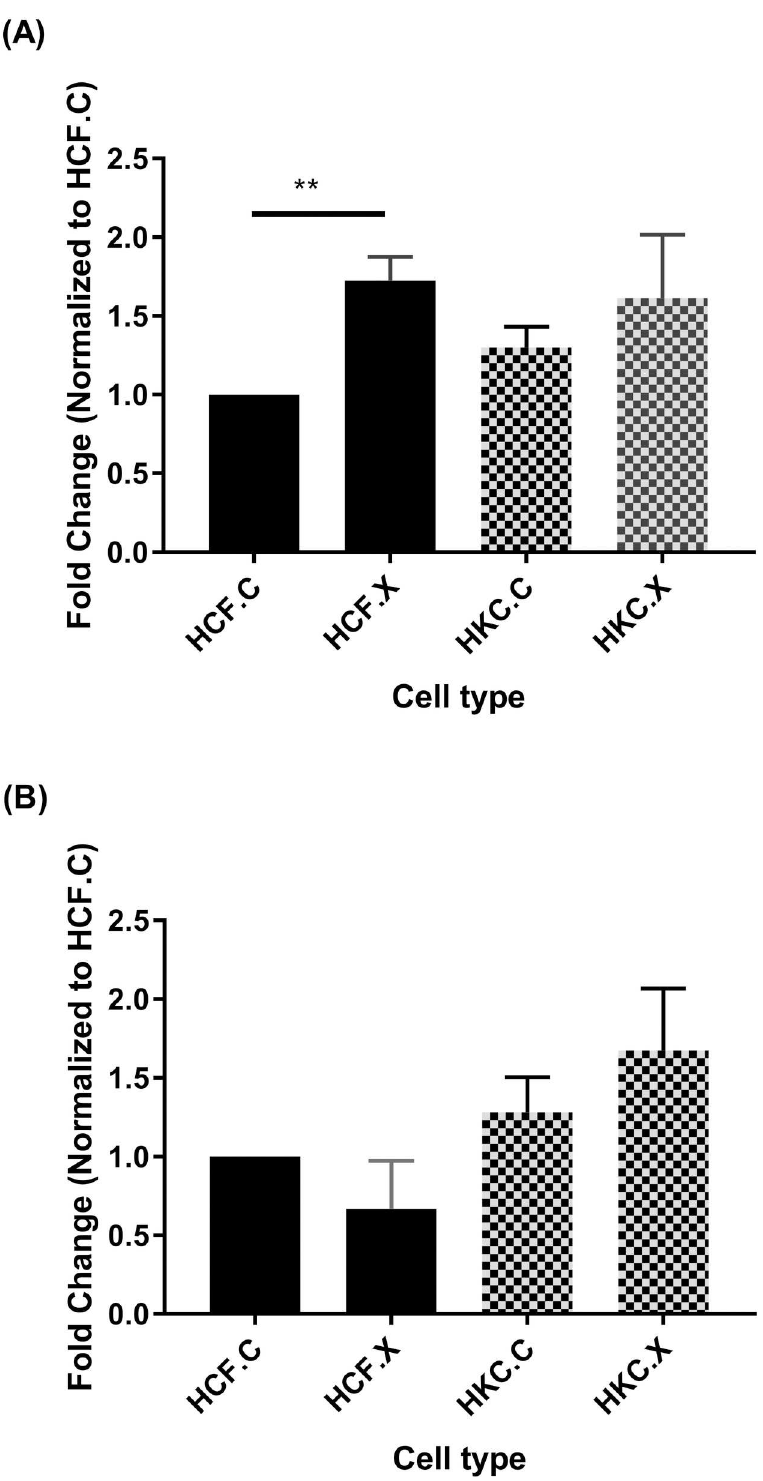
Fig 4. CXL shows no significant impact on protein expression of TIMPs in KC. (A) TIMP1, (B) TIMP2, in HCF.C and HKC.C: pre-CXL, and HCF.X and HKC.X: post-CXL. n = 4. Statistical significance was determined by one way ANOVA, with p (cid:20) 0.05 considered statistically significant. Error bars represent standard error of the mean (cid:3)(cid:3) p < 0.01.